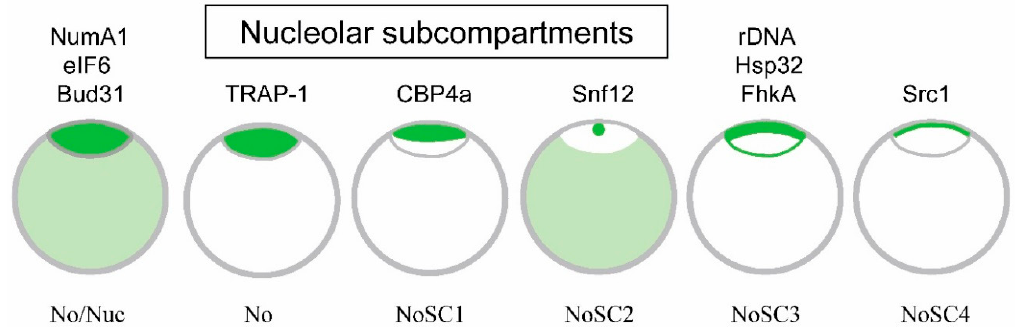
Figure 2. Localization of Dictyostelium nucleolar proteins. Different Dictyostelium nucleolar proteins localize differently as indicated by the green staining. The intensity of the staining summarizes their general differential localization in the nucleolus versus the nucleoplasm. NumA1, eIF6, and Bud31 localize to both the nucleolus and nucleoplasm (No/Nuc), TRAP-1 localizes only to the nucleolus (No), CBP4a localizes only to NoSC1, Snf12 localizes to NoSC2 as well as the nucleoplasm, while Hsp32 and FhkA localize to the nucleolar periphery, possibly representing NoSC3. Src1, a homolog of the helix-extension-helix family, is a questionable nucleolar protein that localizes to a region tentatively labelled NoSC4. The grey lines serve only to indicate the borders of the nucleolus and the nuclear envelope. (modified and updated after [18]).